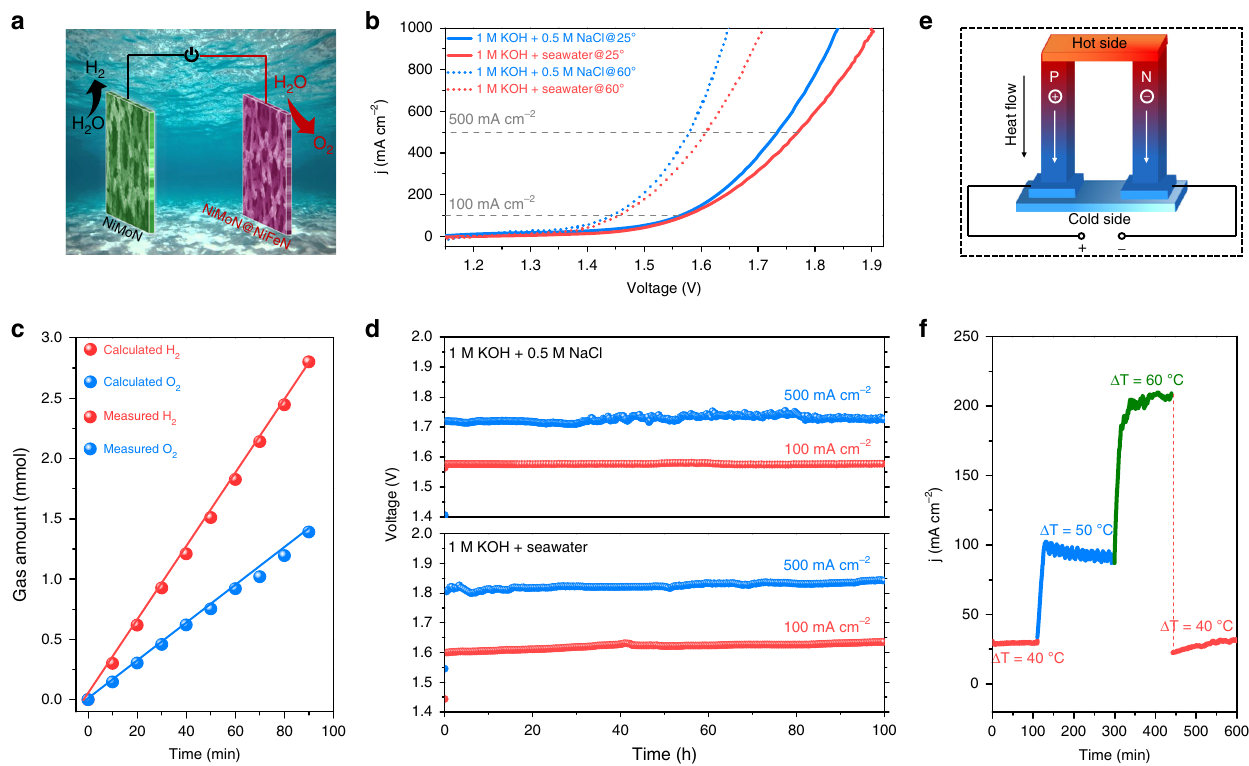
Fig. 4 Overall seawater splitting performance. a Schematic illustration of an overall seawater splitting electrolyzer with NiMoN and NiMoN@NiFeN as the cathode and anode, respectively. b Polarization curves after iR compensation of NiMoN and NiMoN@NiFeN coupled catalysts in a two-electrode electrolyzer tested in alkaline simulated (1 M KOH + 0.5 M NaCl, resistance: ~1.1 Ω ) and natural seawater (1 M KOH + Seawater, resistance: ~1.2 Ω ) electrolytes under different temperatures. c Comparison between the amount of collected and theoretical gaseous products (H 2 and O 2 ) by the two- electrode electrolyzer at a constant current density of 100 mA cm − 2 in 1 M KOH + 0.5 M NaCl at 25 °C. d Durability tests of the electrolyzer at constant current densities of 100 and 500 mA cm − 2 in different electrolytes at 25 °C. e Schematic illustration of the principle for power generation between the hot and cold sides of a TE device. f Real-time dynamics of current densities for the electrolyzer in 1 M KOH + 0.5 M NaCl at 25 °C driven by a TE device when the temperature gradient ( Δ T ) between its hot and cold sides is 40, 50, 60, and 40